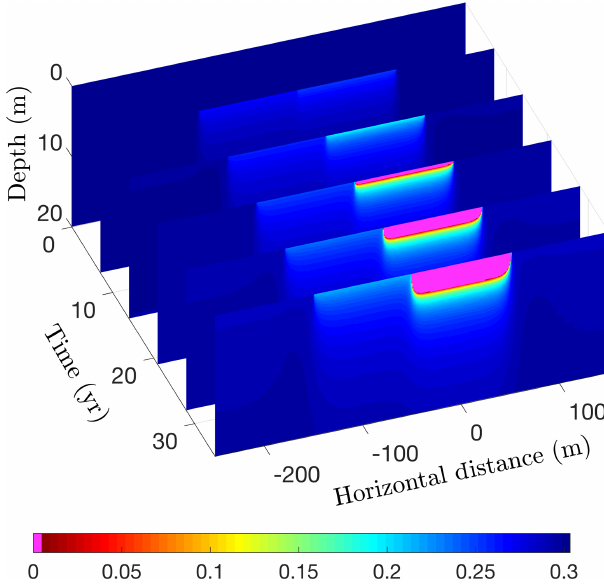
Figure 18. Volume fraction of ice ( φ i ) over a 35-year period follow- ing the creation of a 200m wide lake. Magenta ( φ i = 0) delineates the thaw bulb developing beneath the